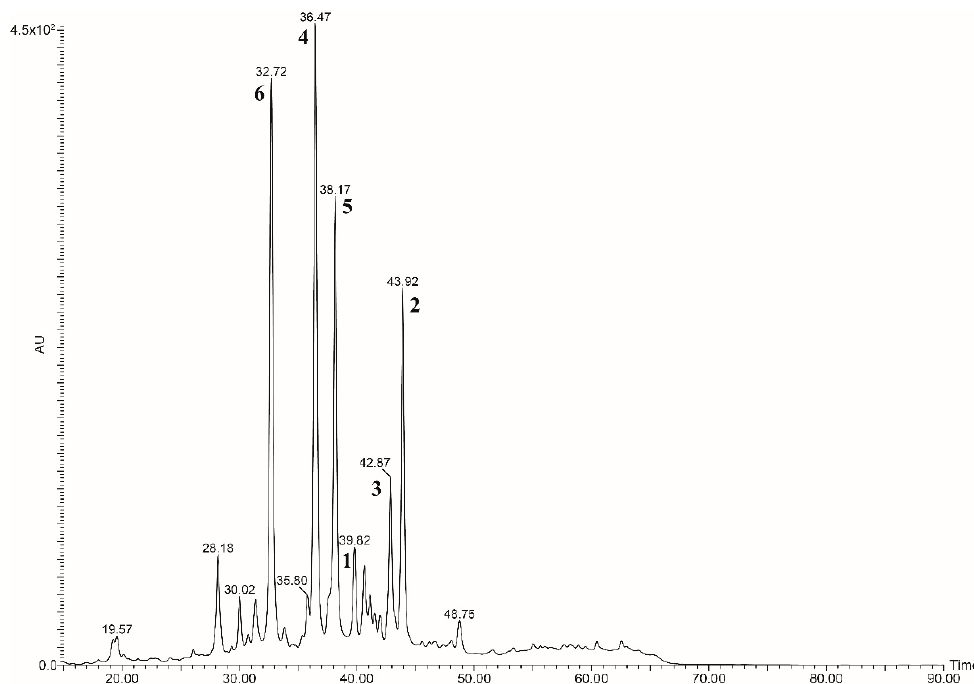
Figure 2. HPLC-UV flavonoid profile of bergamot.